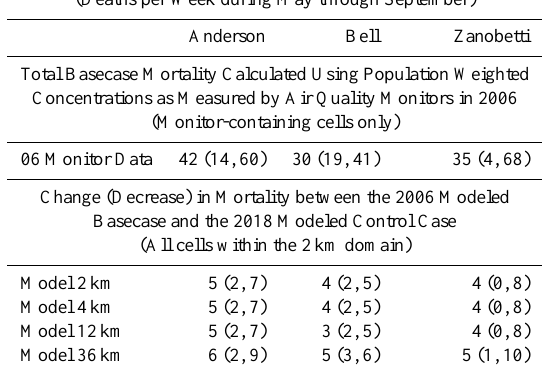
Table 1. Change in mortality for each week of the May through September ozone season for the population located within the HGB area, due to the control scenarios proposed as part of the 2018 Hous- ton Attainment Demonstration versus the 2006 base case. The top row shows baseline weekly mortality due to ozone measured at monitors in 2006. Each entry shows mean value with the 95% con- fidence interval (based on uncertainty associated with concentration response functions only) given in